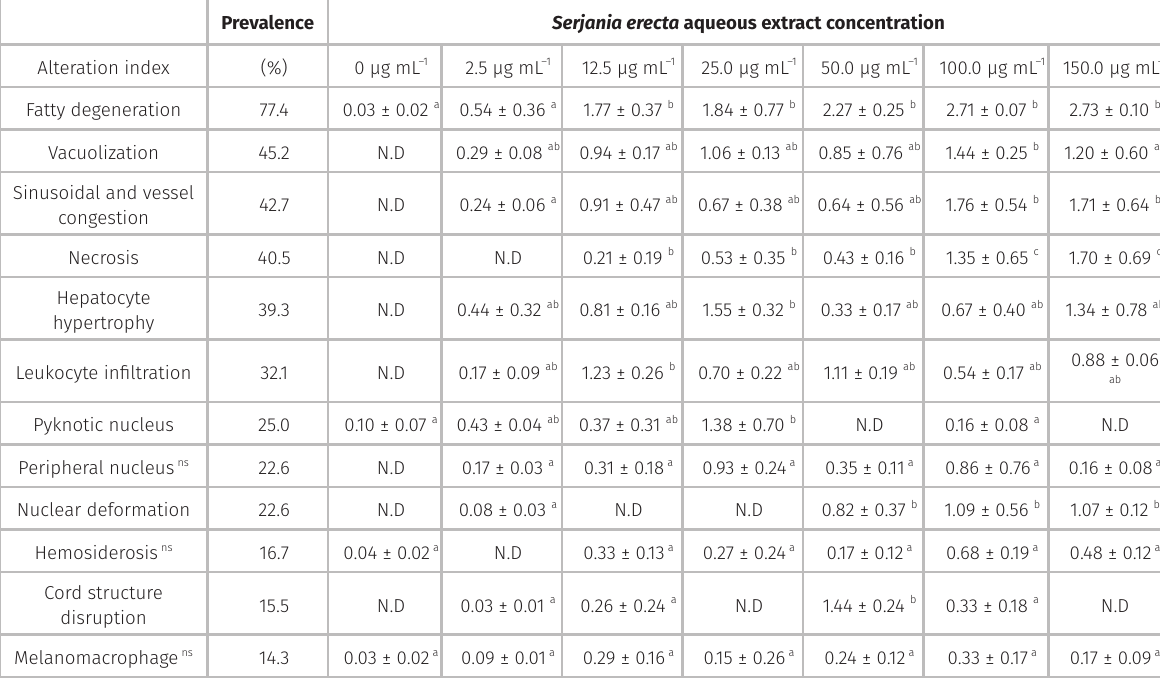
Table V. Prevalence of alterations in the liver of Piaractus mespotamicus exposed to concentrations of Serjania erecta aqueous